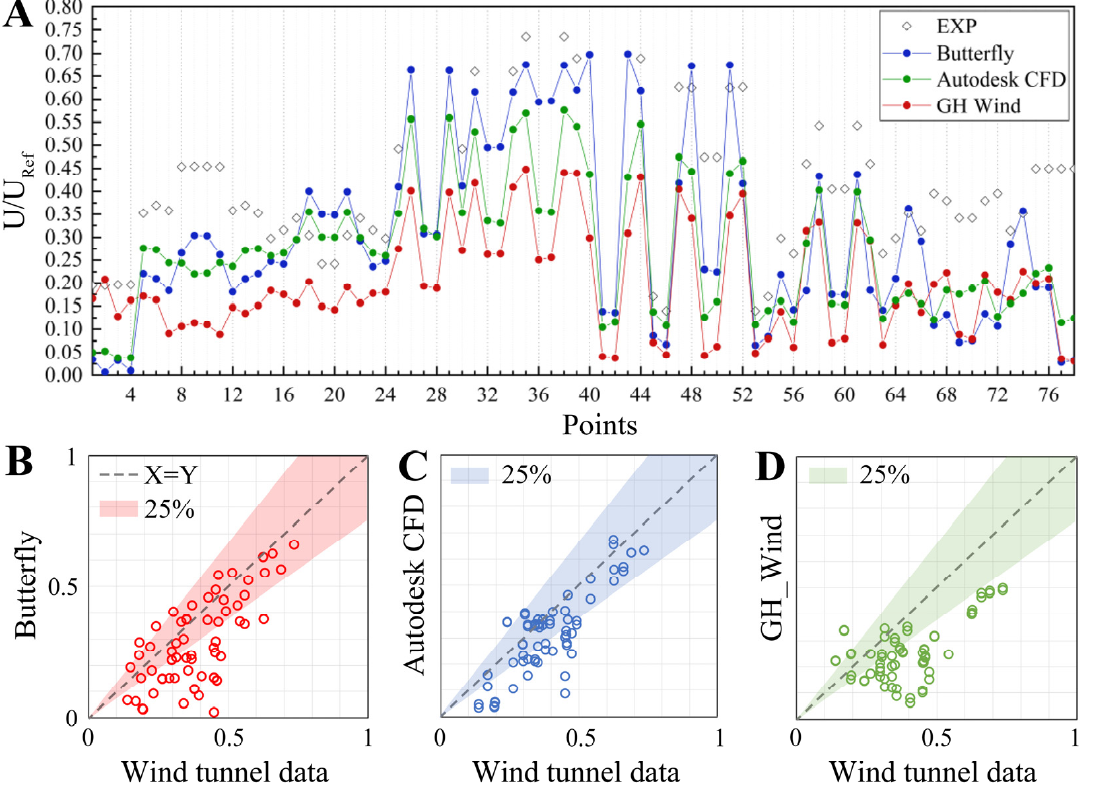
Figure 12. ( A ) The ratio of the wind velocity corresponding to the measured points on the horizontal plane of pedestrian level to the reference velocity (6.65 m/s) when the wind direction is 0 ◦ ; correlation analysis of the simulation results obtained by ( B ) Butterfly, ( C ) Autodesk CFD, and ( D ) GH_Wind and wind tunnel data, respectively. Shaded regions in ( B – D ) mark the prediction envelopes with allowable errors of less than